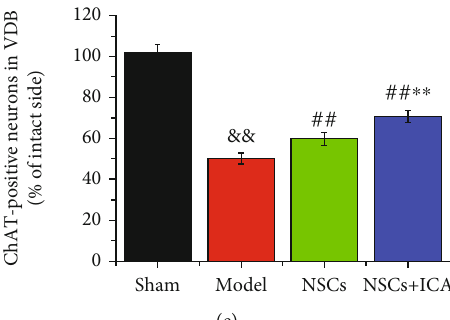
Figure 6: Combination of NSC transplantation and ICA treatment increased the total number of cholinergic neurons in the basal forebrain of FFT rats. (a) Immuno fl uorescent staining of BrdU (A1, green) and ChAT (A2, red) showed NSCs di ff erentiated into cholinergic neurons in vivo . Scale bar = 25 μ m . (b) Immuno fl uorescent staining of ChAT in the medial septum (MS) of the ipsilateral and contralateral sides in FFT rats. Scale bar = 100 μ m . (c) Quantitative analysis of the ratio of ChAT(+) neurons in the ipsilateral side compared to contralateral side (intact side) in MS of FFT rats. (d) Immuno fl uorescent staining of ChAT in the vertical limb of the diagonal band (VDB) of the ipsilateral and contralateral sides in BF of FFT rats. Scale bar = 100 μ m . (e) Quantitative analysis of the ratio of ChAT(+) neurons in the ipsilateral side compared to the contralateral side (intact side) in VDB of FFT rats. Data are expressed as the mean ± SEM , n = 3 . && P < 0 : 01 , the FFT model group vs the sham group; ## P < 0 : 01 , the NSC transplantation group vs the FFT model group; ∗∗ P < 0 : 01 , the NSC + ICA group vs the NSC transplantation group. ChAT: choline acetyltransferase (a marker of cholinergic